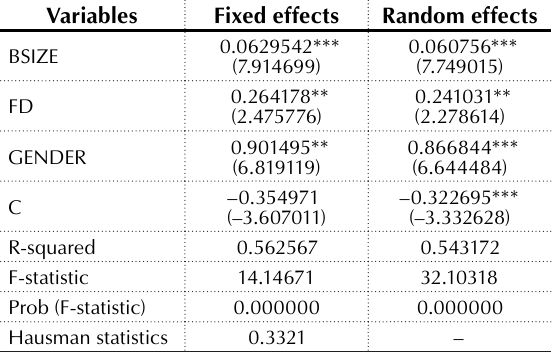
Table 6. Regression result for (panel fixed effects can